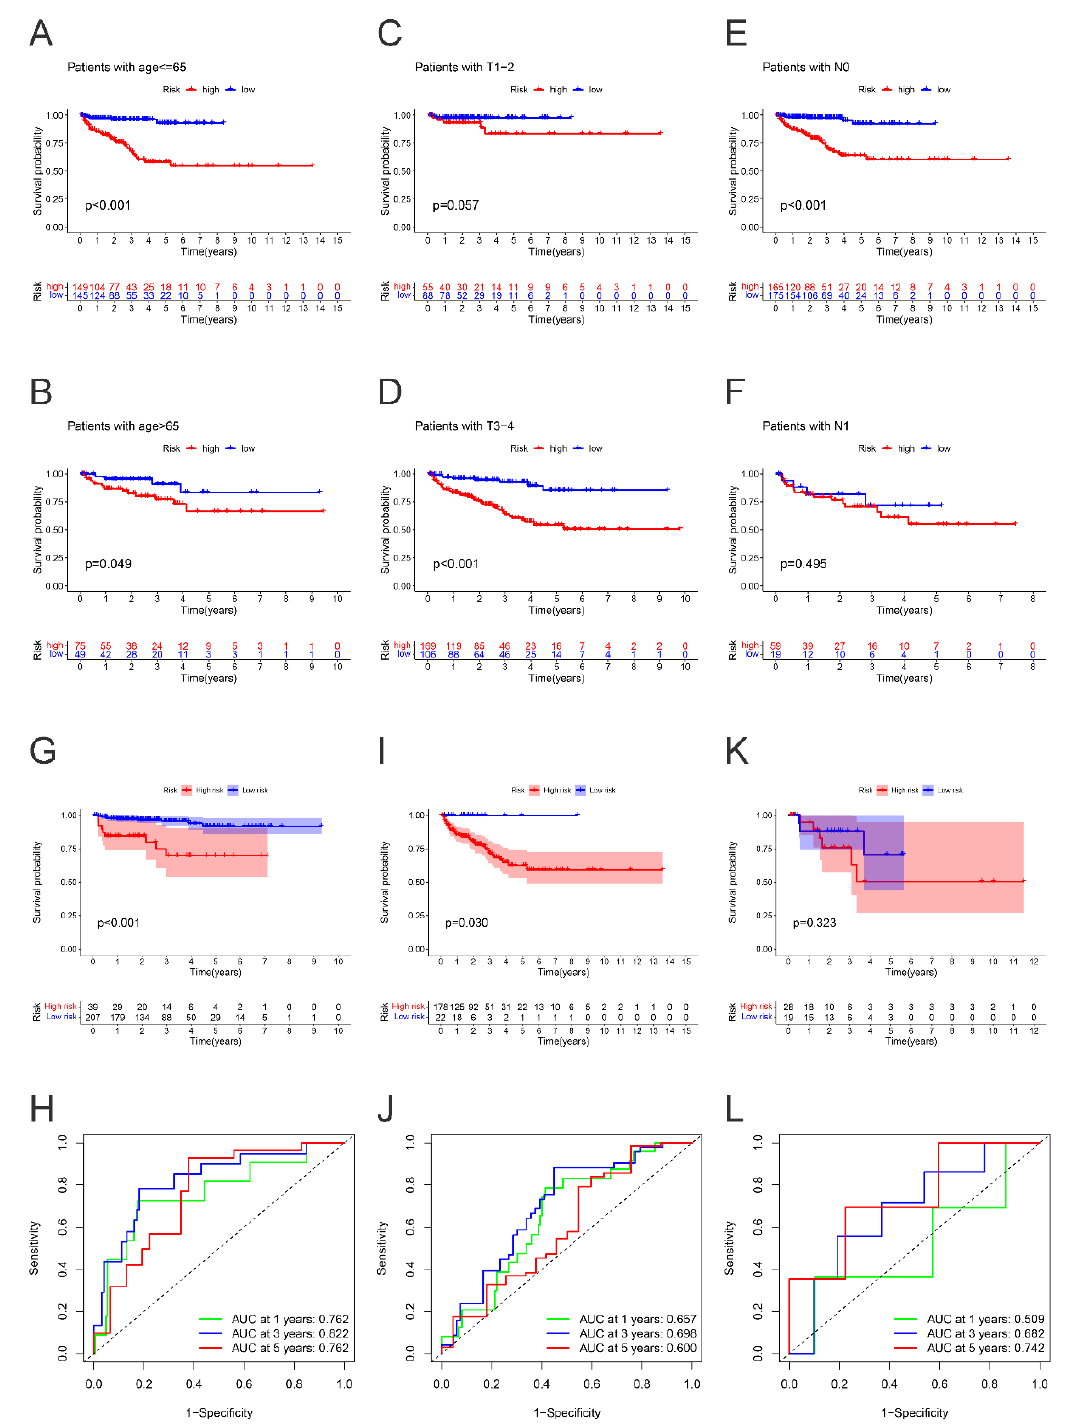
Figure 5. The subgroup survival analysis between high- and low-risk groups in PCa patients of age ≤ 65 ( A ), age > 65 ( B ), T stage 1–2 ( C ), T stage 3–4 ( D ), N0 stage ( E ), N1 stage ( F ). The survival analysis between high- and low-risk groups, and corresponding area under ROC curve in cluster 1 cohort ( G , H ), cluster 2 cohort ( I , J ), cluster 3 cohort ( K , L ). Additionally, the following studies revealed that PCa patients with a high-risk score was related to significantly worse BCRFS in cluster 1 ( p < 0.001) and cluster 2 ( p = 0.030). Respectively, in cluster 3, we did not evaluate the marked difference of BCRFS between two subgroups in cluster 3 ( p = 0.323). Additionally, the AUC for predicting BCRFS